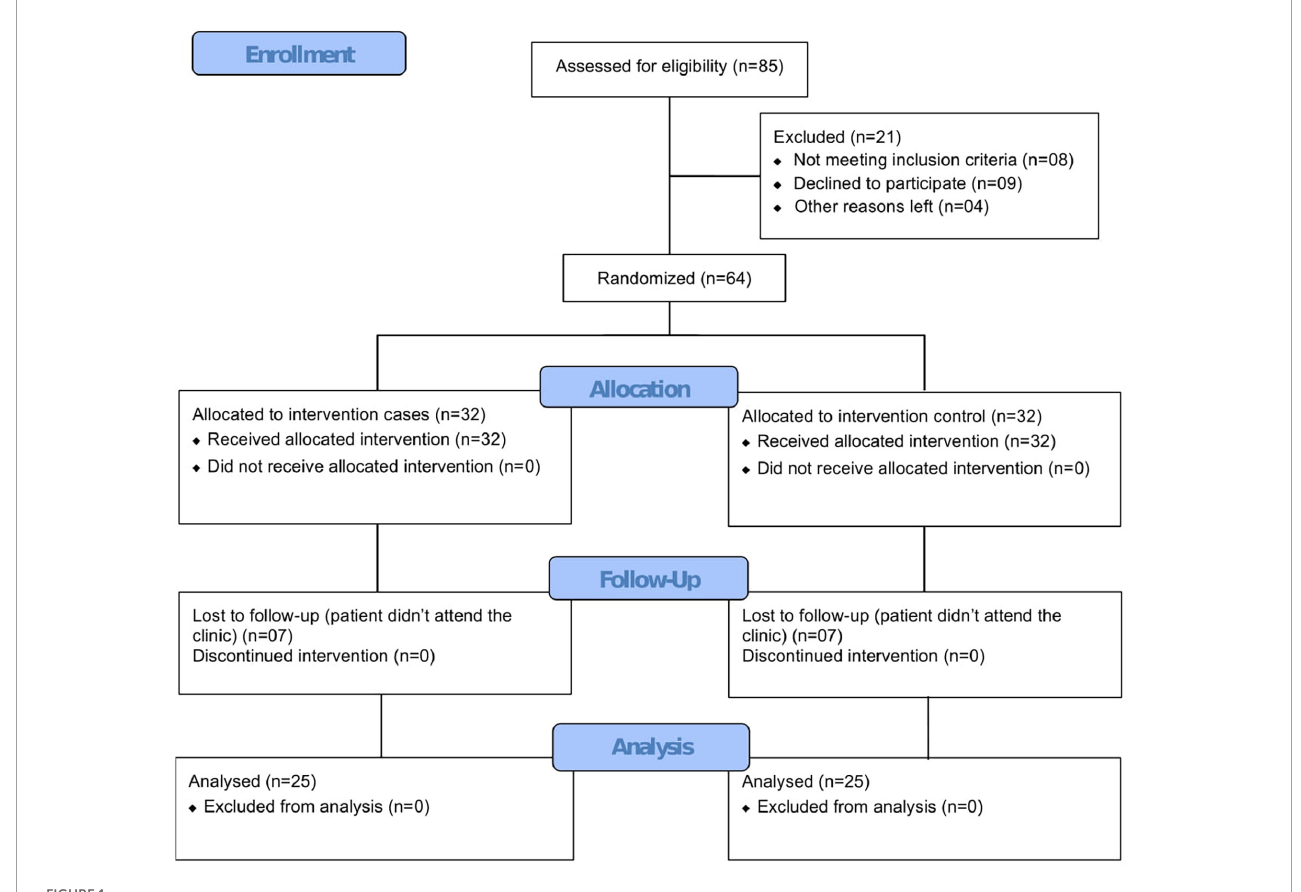
FIGURE1 Study CONSORT flow